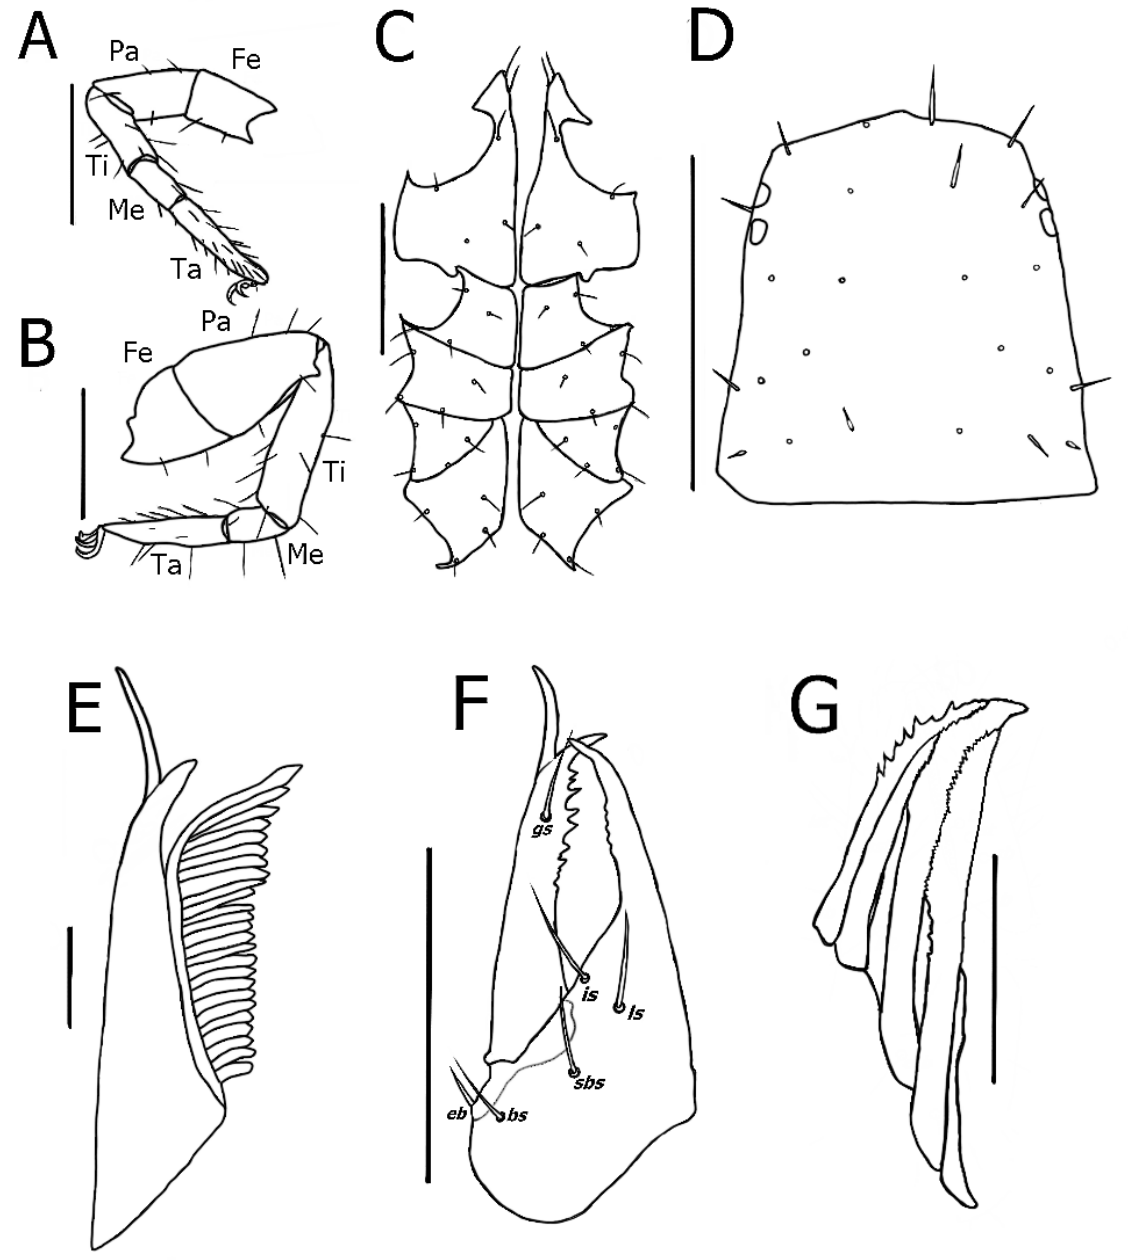
Fig. 7. Ideobisium kichwa sp. nov., ♀♀. A . Leg I. B . Leg IV. C . Coxa. D . Carapace. E . Serrula exterior. F . Chelicera in dorsal view, showing trichobothria and galea. G . Rallum. A–F: holotype (QCAZ); G: paratype (ZMH A0003687). Abbreviations: Fe = femur; Me = metatarsus; Pa = patella; Ta = tarsus; Ti = tibia. Scale bars: A–C, F = 0.25 mm; D = 0.50 mm; E = 50 µm; G = 30